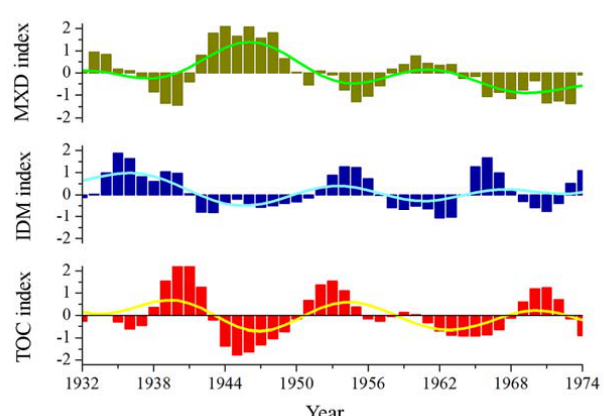
Fig. 9: Time series of normalized indices MXD, IDM, and TOC (correlating with UV-B)